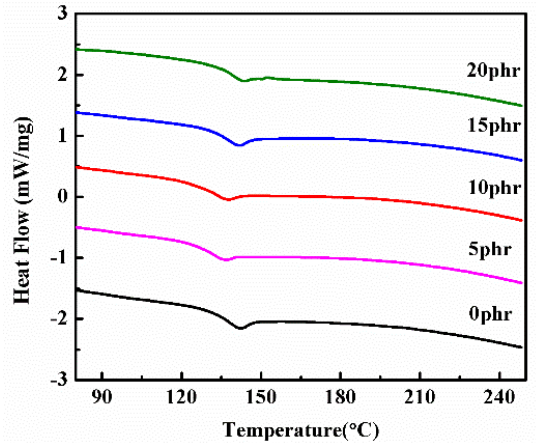
Figure 12. DSC curves of PSF/epoxy cured products with different PSF contents.